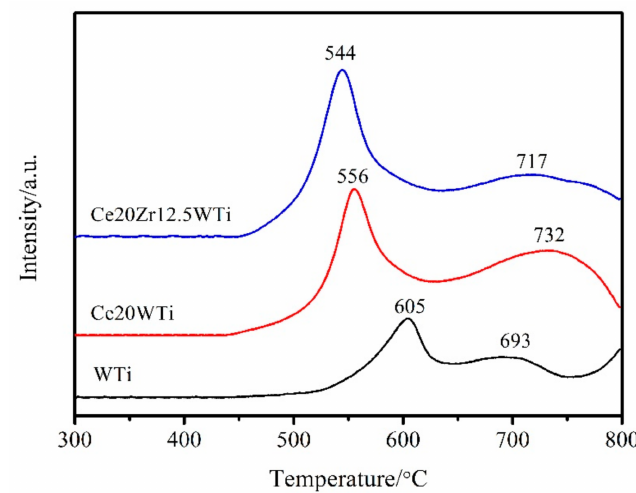
Figure 6. H 2 -TPR profiles of Ce x Zr y WTi catalysts.